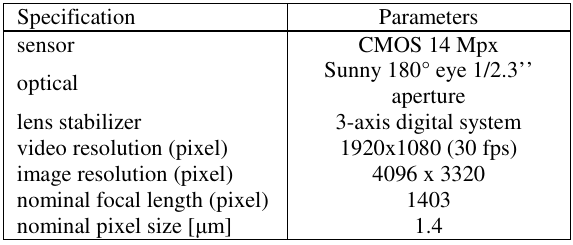
Table 1. Technical specifications of Bebop image acquisition